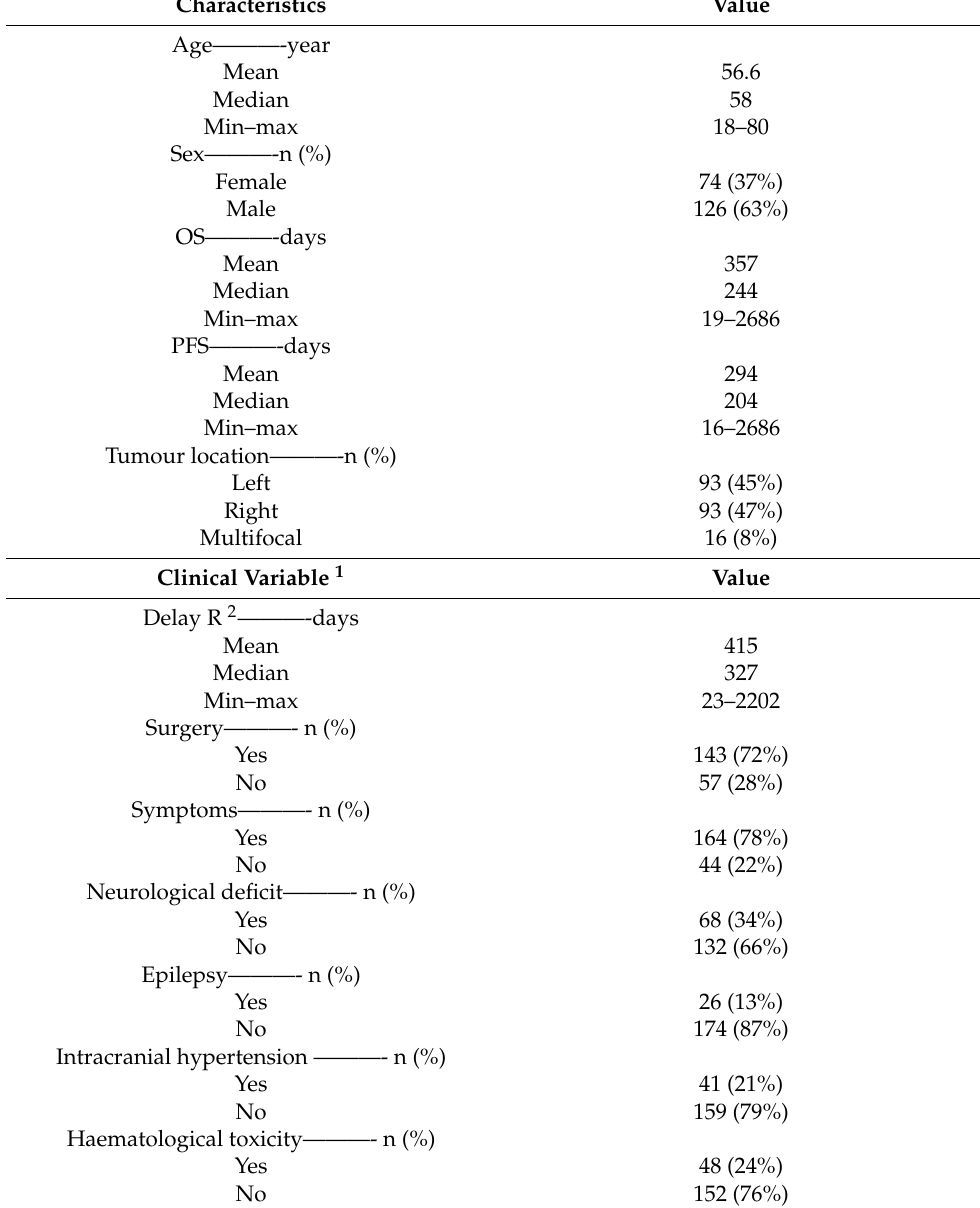
Table 1. Patient